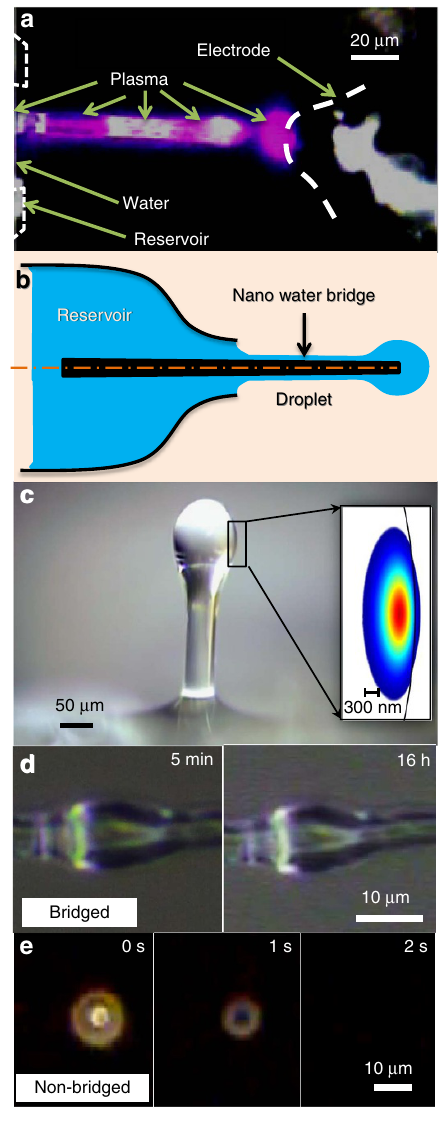
Figure 1 | Droplet sustainer. ( a ) A silica stem is plasma treated to modify its hydrophilicity. A water microdroplet is then formed near the stem’s end (( b ) right) while in fluidic contact with a water reservoir (( b ) left) via a nano water bridge covering the stem (( b ) centre). ( c ) Micrograph of the drop together with its calculated mode (inset). ( d ) The bridged droplet maintained its shape for 16h. ( e ) Control group: evaporation of a non- bridged droplet on a plate. Vertical and horizontal configurations were equivalent here, since gravity is negligible when compared with surface